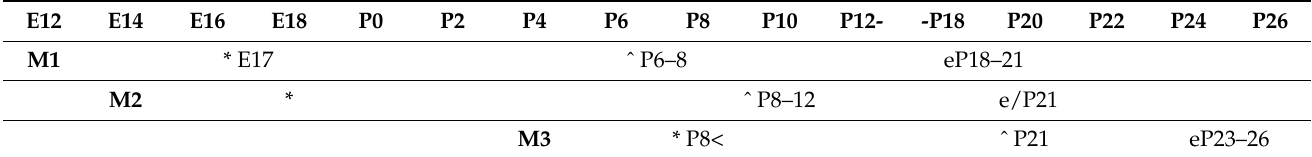
Table 3. Bar chart of prenatal and postnatal stages of onset (leftmost end of each row). This chart indicates the start (*) and completion (ˆ) of crown mineralization, and emergence (e) of first (M1), second (M2) and third molar (M3) teeth in C57BL/6J mice. Staging is based on our image data from embryonic (E) stage E10 to postnatal (P) age 26. Total duration of development is comparable among all three molars (M1, M2, M3). Periods of M1 and M2 morphogenesis and crown formation largely overlap with each other but do not overlap with those of M3 because of its later onset by about 10 days after birth. * = start of crown mineralization, ˆ = crown completion, e = emergence into